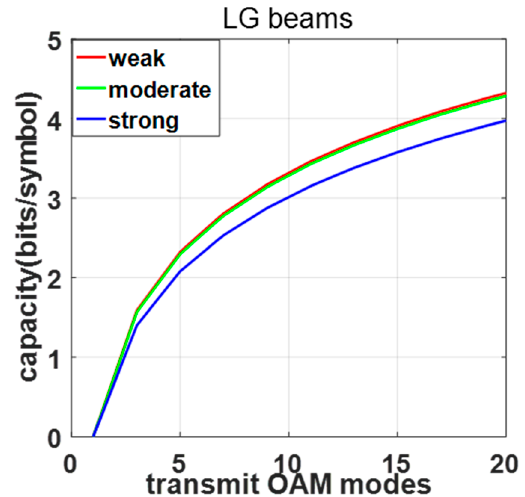
Figure 11. Variance of channel capacity with different OAM modes.